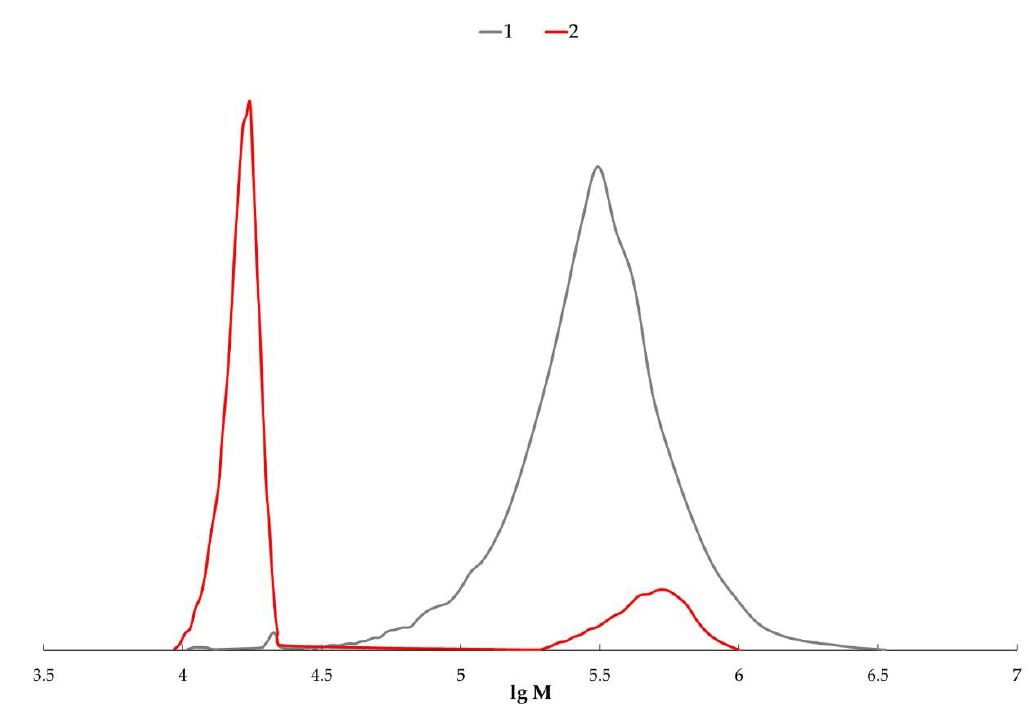
Figure 8. MWD curves of ( 1 ) gelatin; ( 2 ) graft Gel-PMMA copolymer synthesized in the presence of TBB and 2,5-DTBQ (Gel:MMA = 1:1).